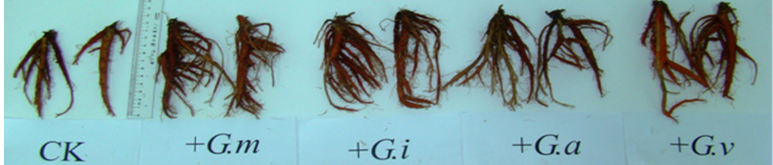
Table 2. Effect of AMFs inoculation on shoot growth traits of S. miltiorrhiza seedlings. Treatment Plant Height (cm) Leaf Number Leather Leaf Length